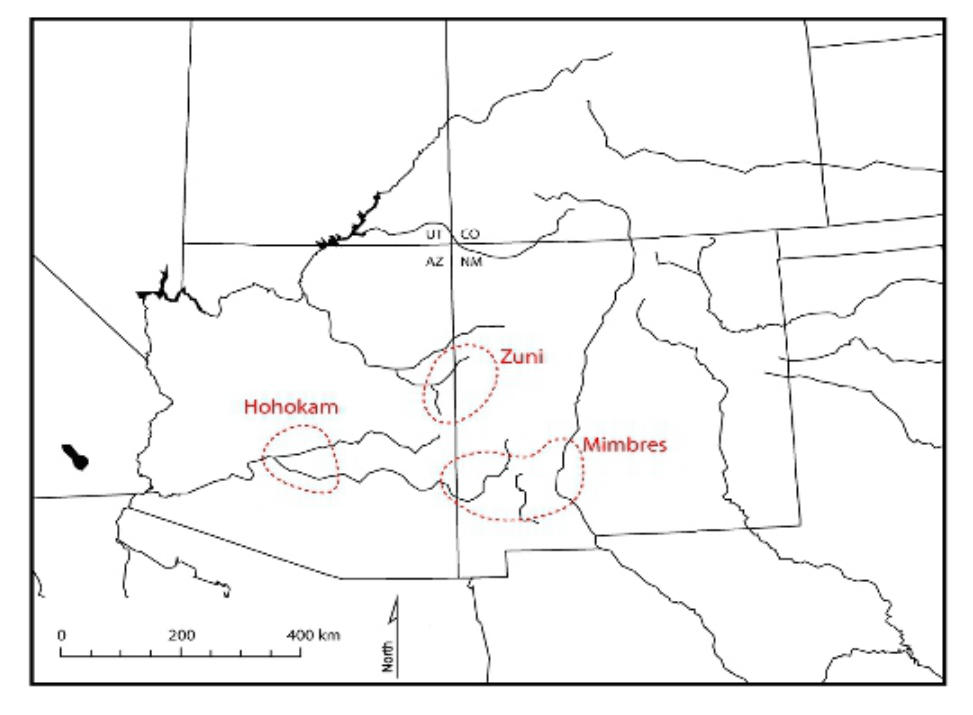
Fig. 1. The location of the case studies in the U.S.